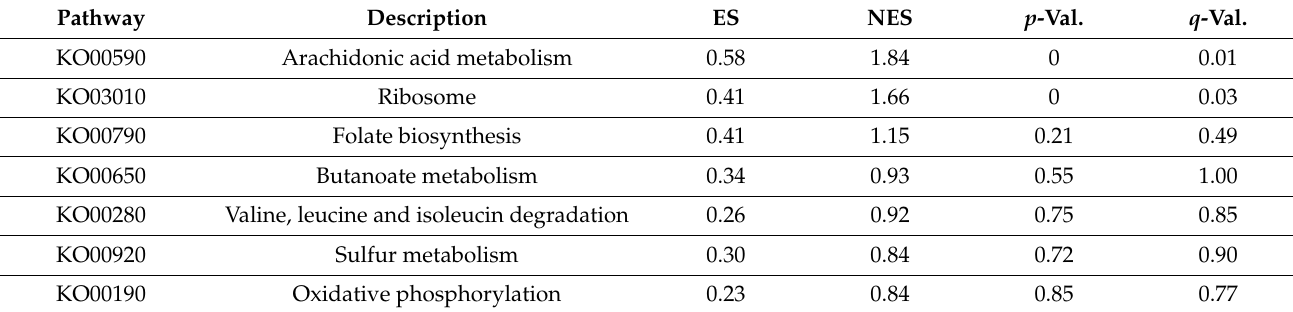
Table 4. Gene set enrichment analysis of KEGG pathways in response to the 5-AzaC treatment of S. japonica . Pathway